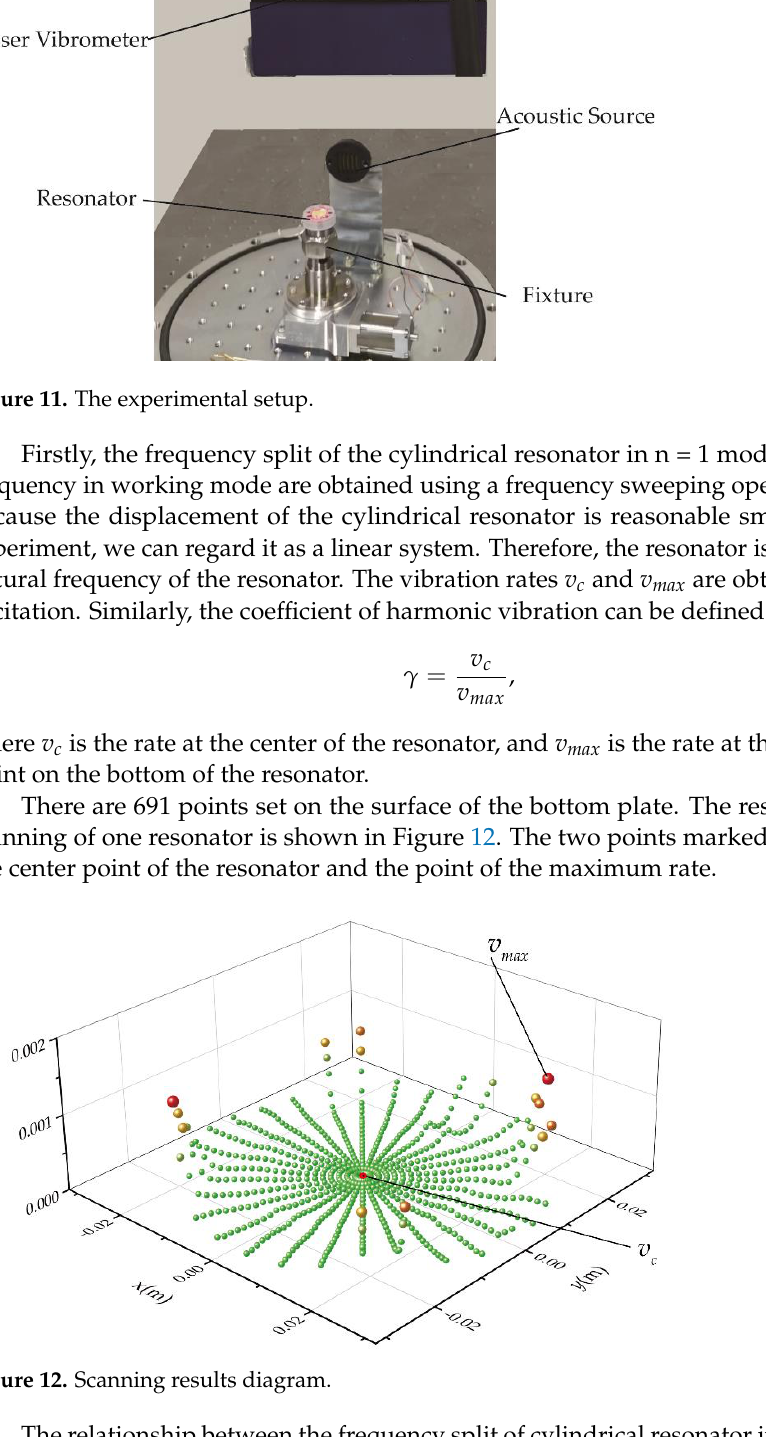
Table 2. Vibration frequency, frequency split under n = 1 mode, and coefficient of harmonic vibra- tion of experimental resonators. Resonator Number